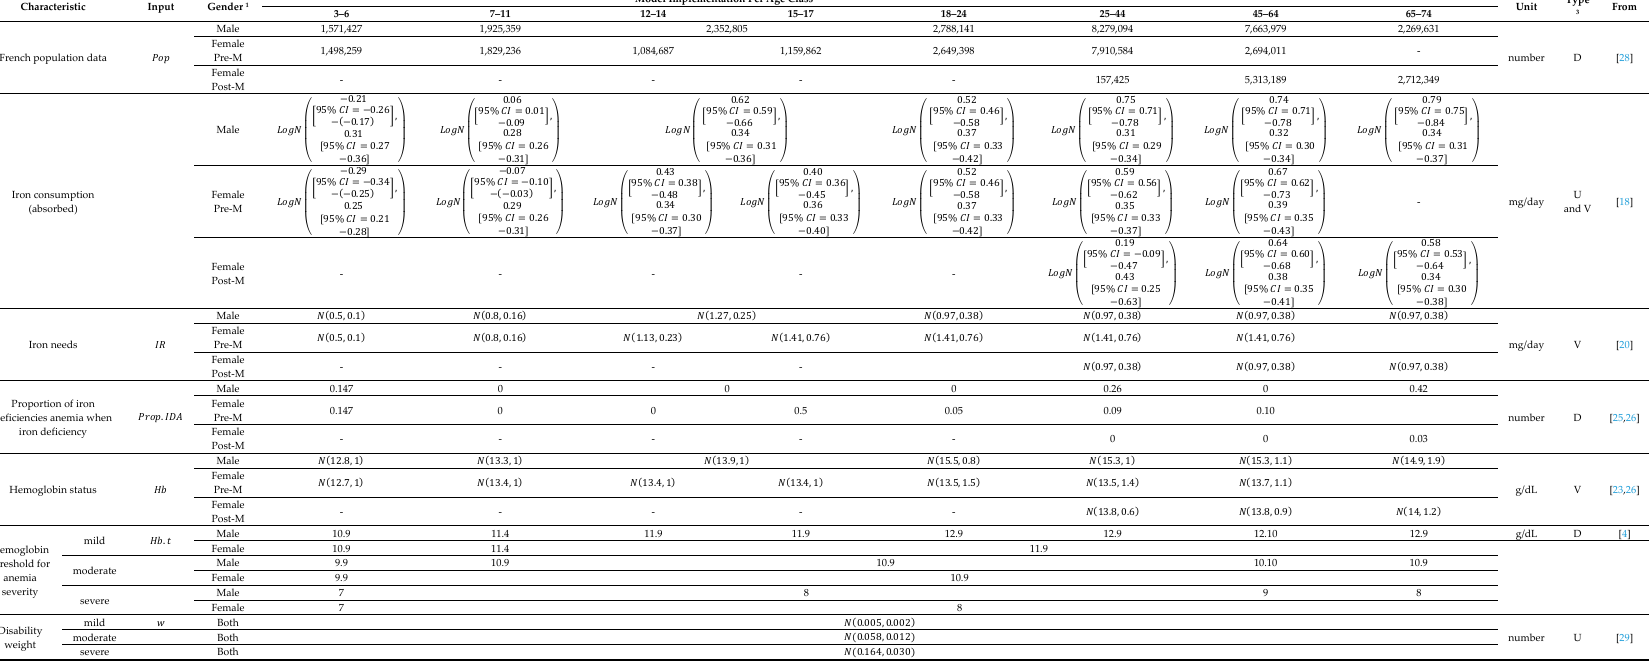
Table 1. Sources of information and implementation of the inputs either as deterministic values or as probability distributions.